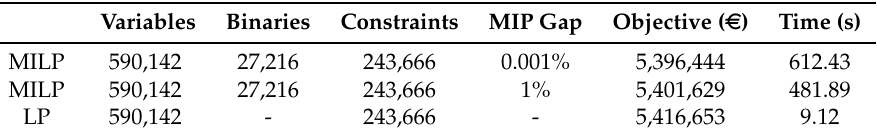
Table 1. Example numbers for problem size and calculation time for the mixed-integer and linear model version for a 27-scenario, 168 h